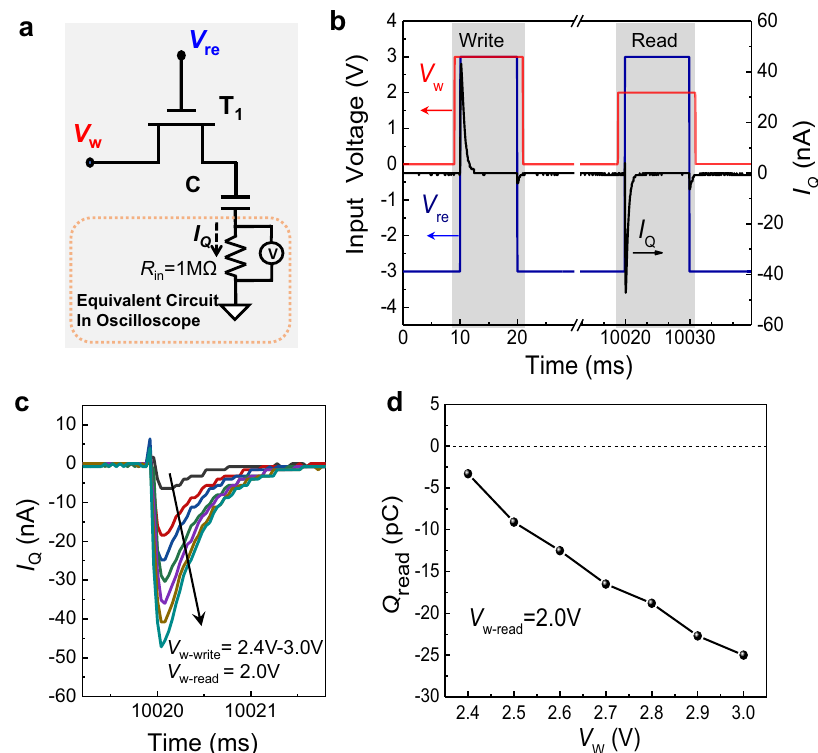
Fig. 2 Characterization of the 1T – 1C storage module. a Schematic diagram of the electrical circuit used to measure the 1T – 1C storage module (shadow area). The equivalent circuit in the dashed box equals an external oscilloscope connected to the capacitor. b Input voltage waveform ( V w , V re ) and readout current ( I Q ) vs. measurement time. c I Q spikes at V re = 3 V while V w − write ranges from 2.4 to 3 V in 0.1 V steps. d Calculated retained charge ( Q read ) in the capacitor as a function of V w − write (compared with V w − read = 2.0 V when I Q = 0 (Fig. 2c), which approximately equals the write time. The integral of the current overtime during a read cycle equals the charge Q read remaining after the waiting interval (10 s). In Fig. 2d, the calculated Q read vs. V w curve is linear, indicating that the charge saved on the capacitor can still be differentiated after 10 s.